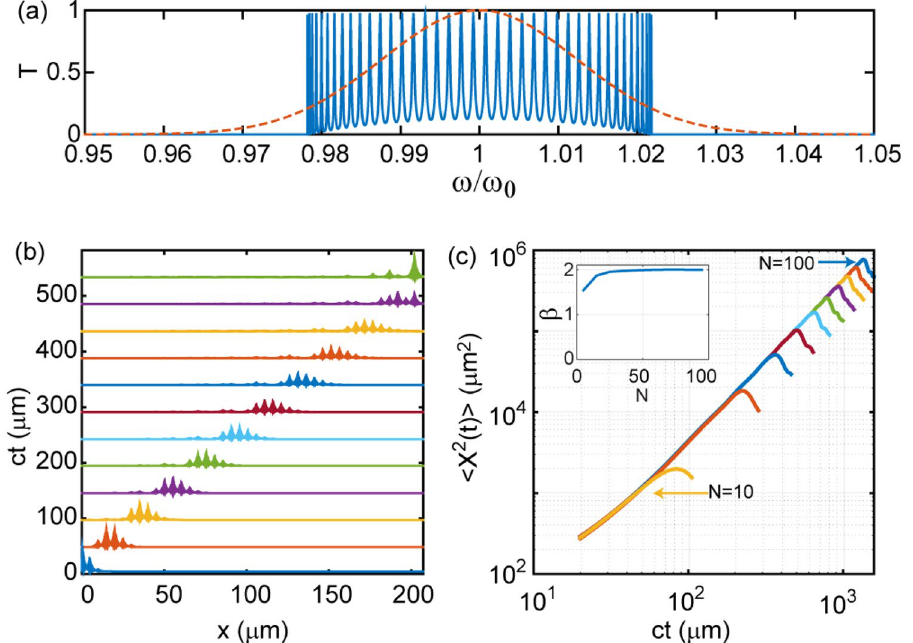
Figure 2. ( a ) Transmission spectrum of N = 40 cavities of λ n /2 separated from each other by periodic Bragg reflectors made of 20 alternating layers of refractive